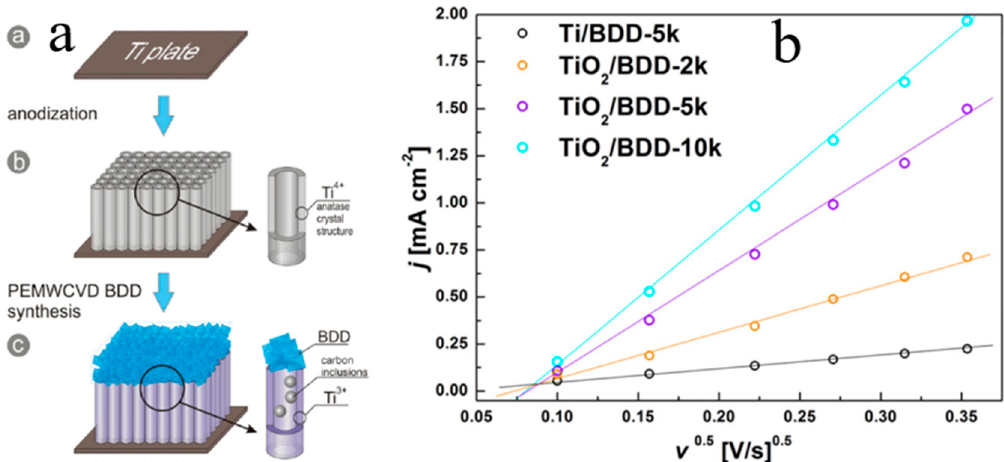
Figure 19. Schematic illustration for composite TiO 2 NTs/BDD electrode. Cyclic voltammetry plots: ( a ) combination electrodes TiO 2 NTs/BDD-10 k, with pure TiO 2 and BDD immersed in 0.1 M NaNO 3 ( ν = 50 mV/s), ( b ) the curve of peak currents versus the square root of the scan rate for different BDD-covered electrodes [70,105,106].